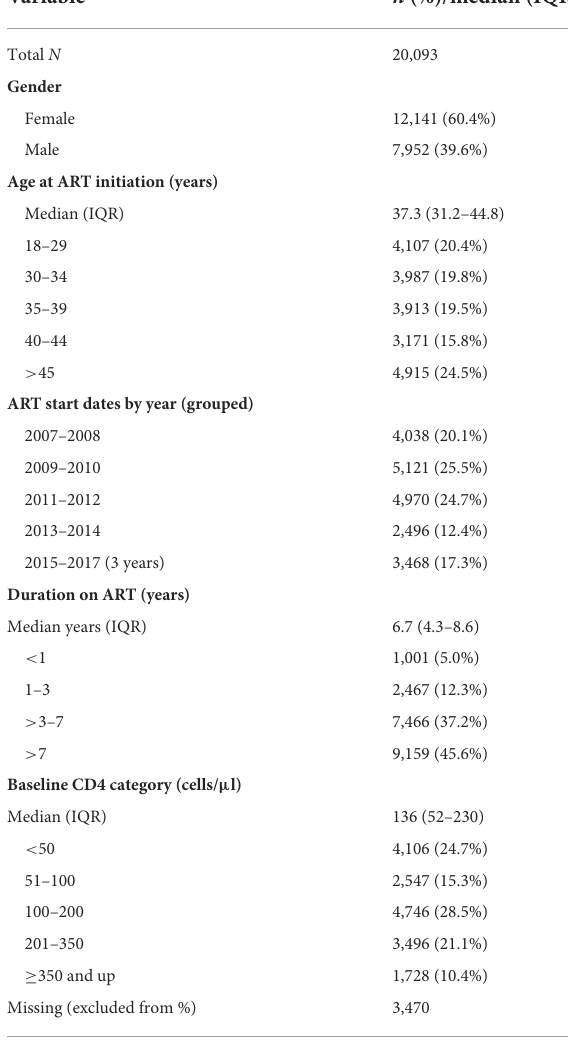
TABLE 2 Characteristics at ART initiation of patients forming the study sample from Themba Lethu Clinic in Johannesburg, South Africa ( n =